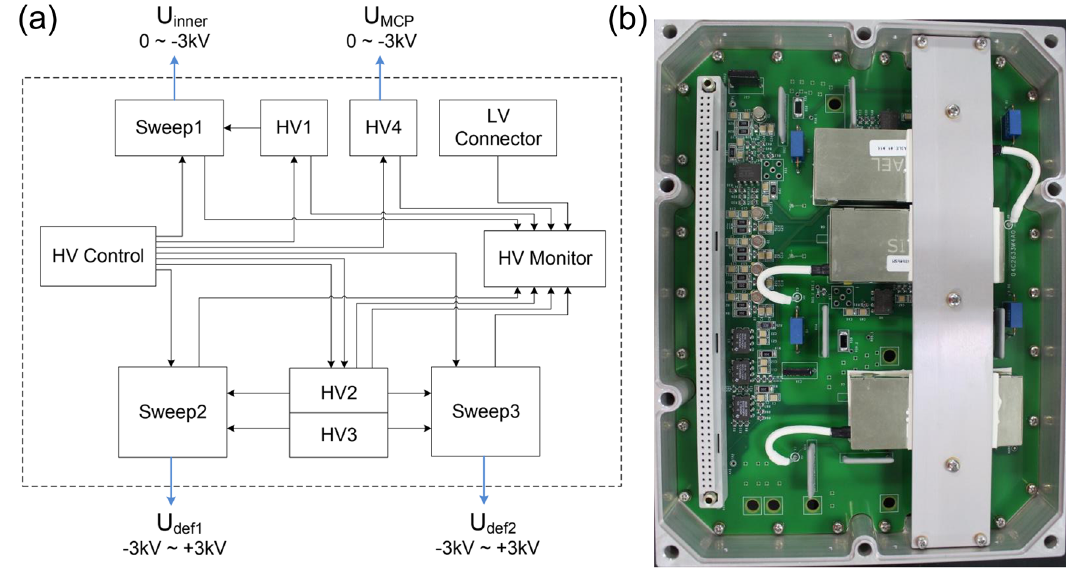
Figure 3: ( a ) Schematics of the HVU and ( b ) photograph of its